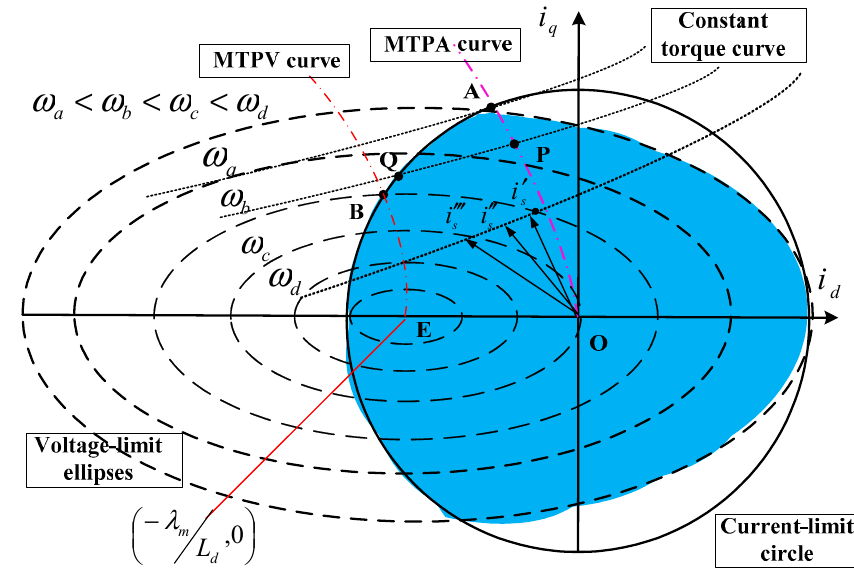
Figure 1. Curves under the drive current and voltage constraints.